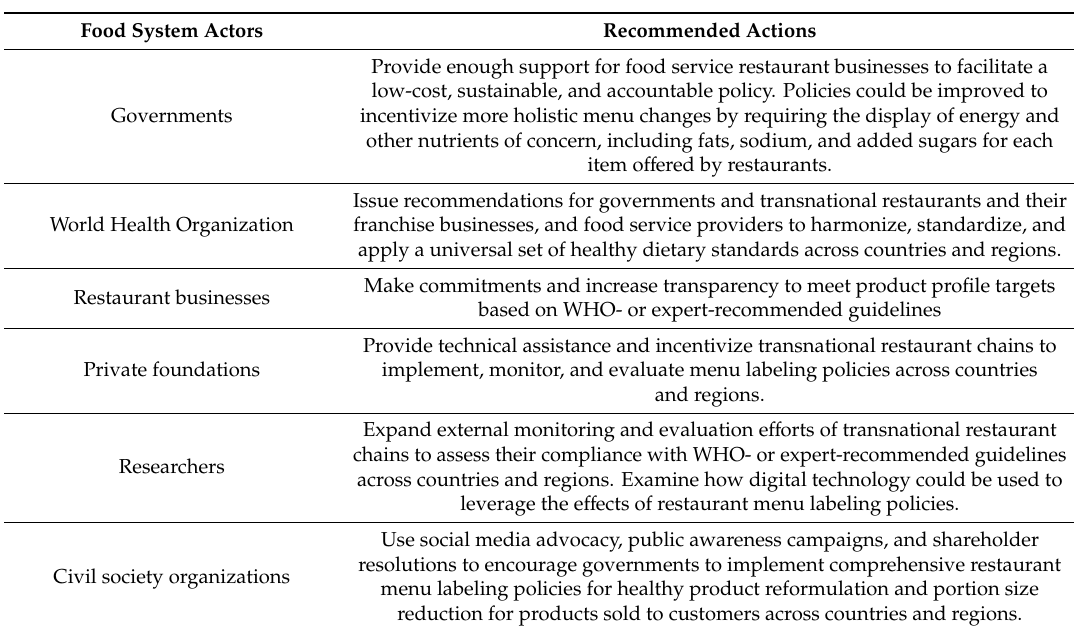
Table 5. Recommended actions for stakeholders to develop, implement, and evaluate comprehensive restaurant menu labeling